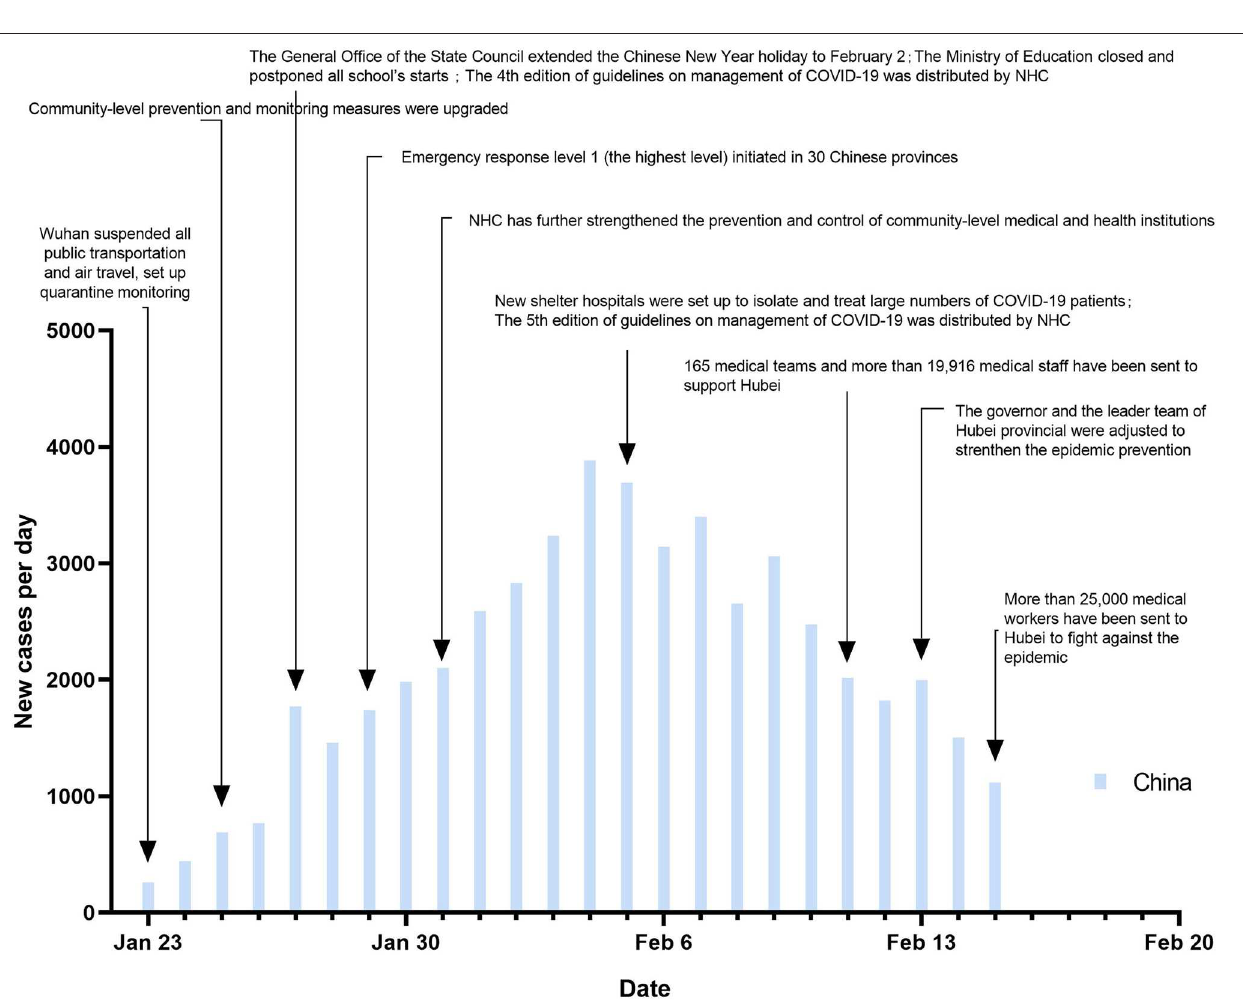
FIGURE 5 | Major prevention and control measures in China since January 23, 2020.